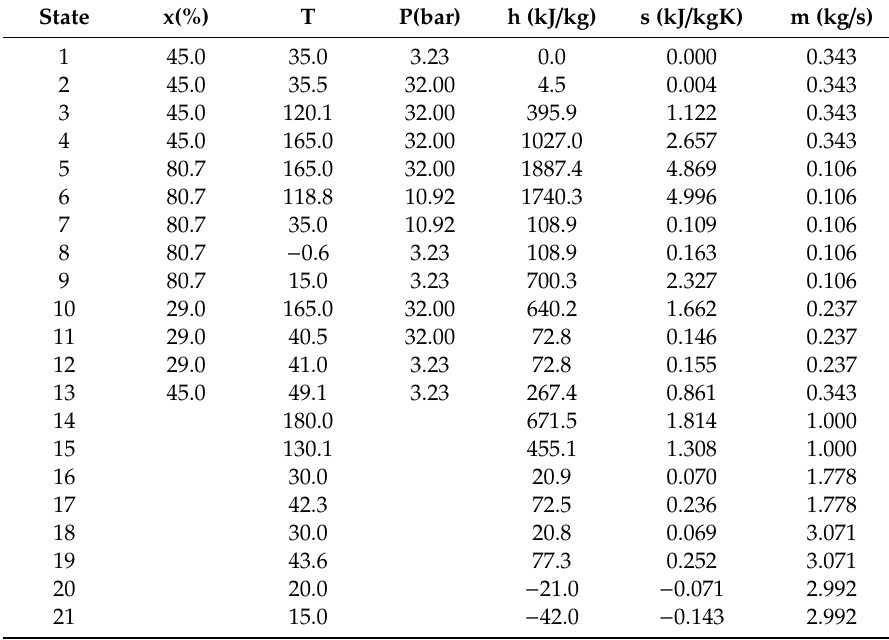
Table 2. Thermodynamic properties and mass flow rate for the stream in the